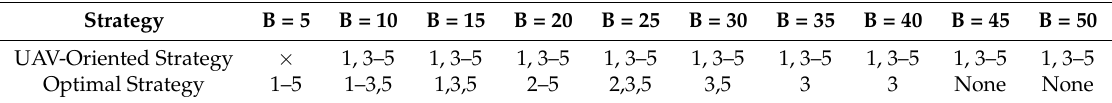
in Figure 3. “None” implies that UAV visits all CH robots if B = 45 or B = 50. “ × ” implies that the UAV-oriented Strategy is infeasible for that battery